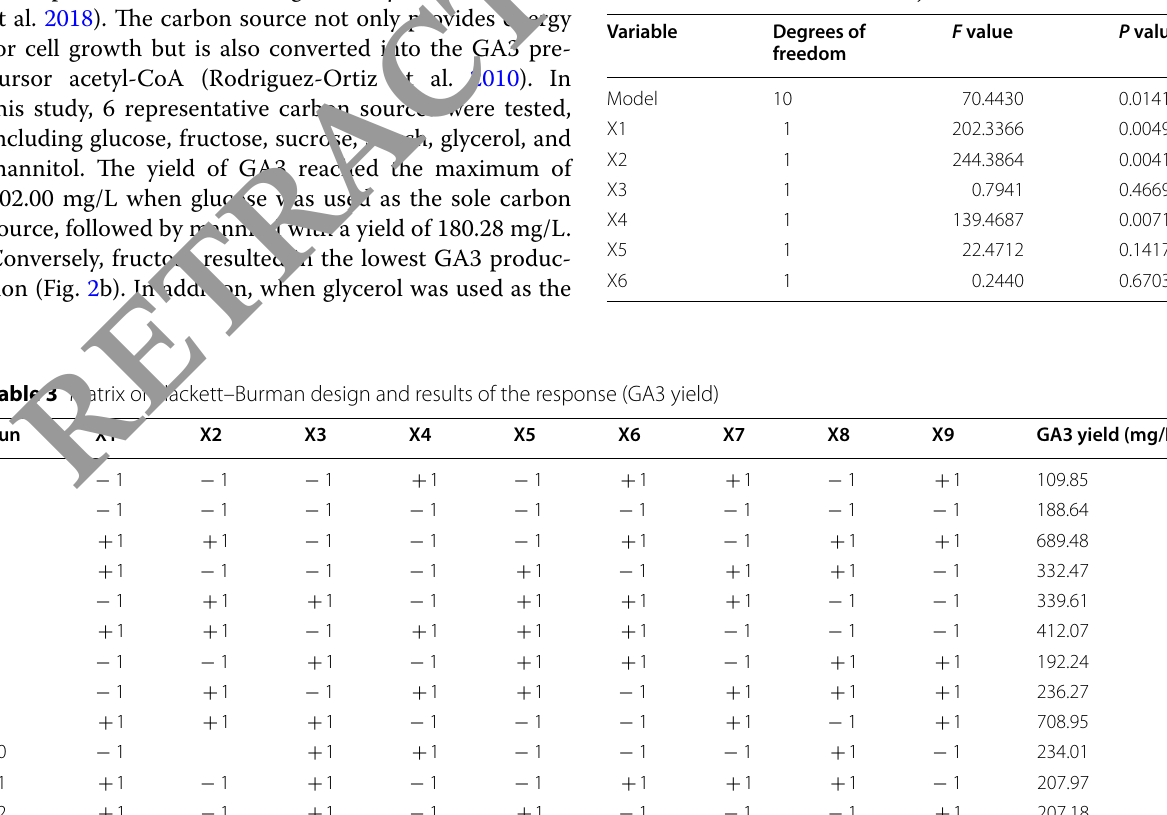
Table 4 Effects and statistical analysis of